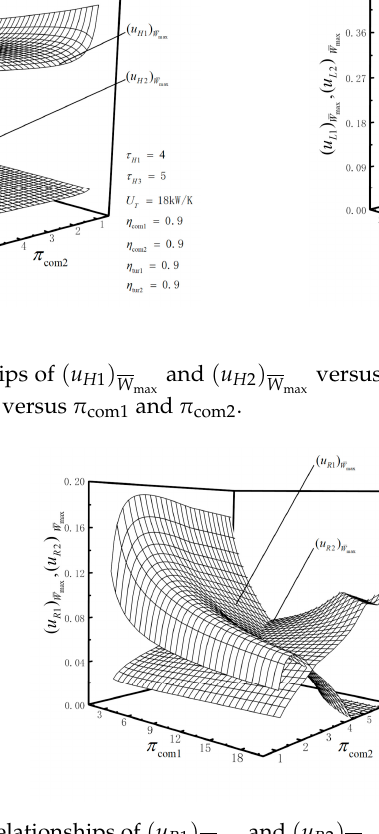
versus π com1 and π com2